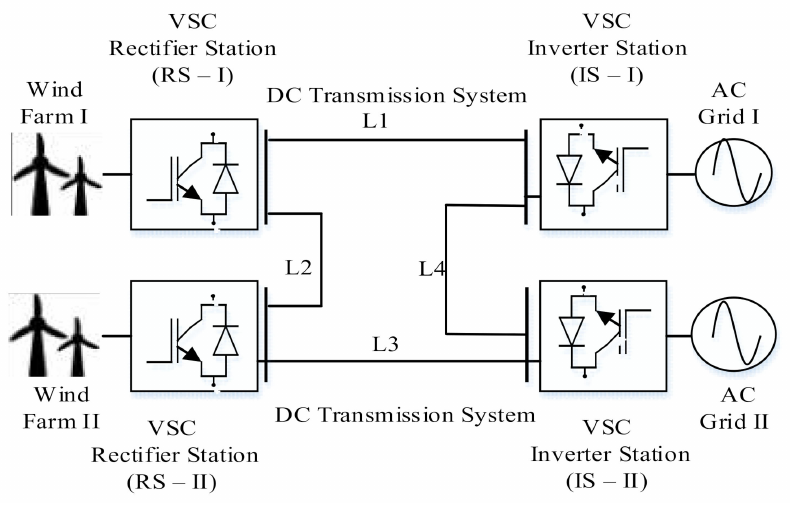
Figure 10. Multi-terminal high voltage direct current (MT-HVDC) test